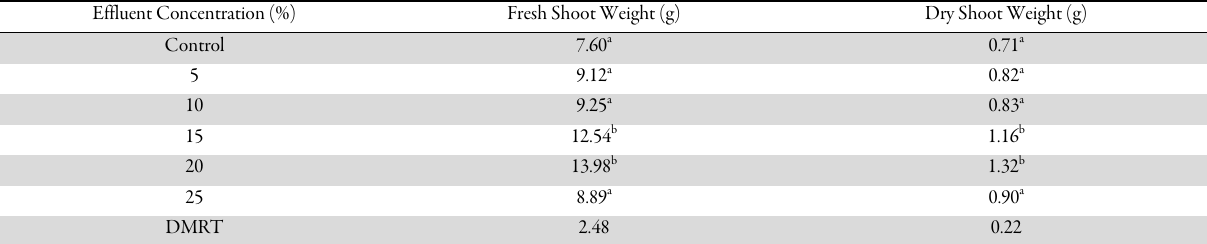
Table 5. Fresh and dry weight of shoot of Solanum lycopersicum treated with different concentrations of effluent at 16WAP Effluent Concentration (%)